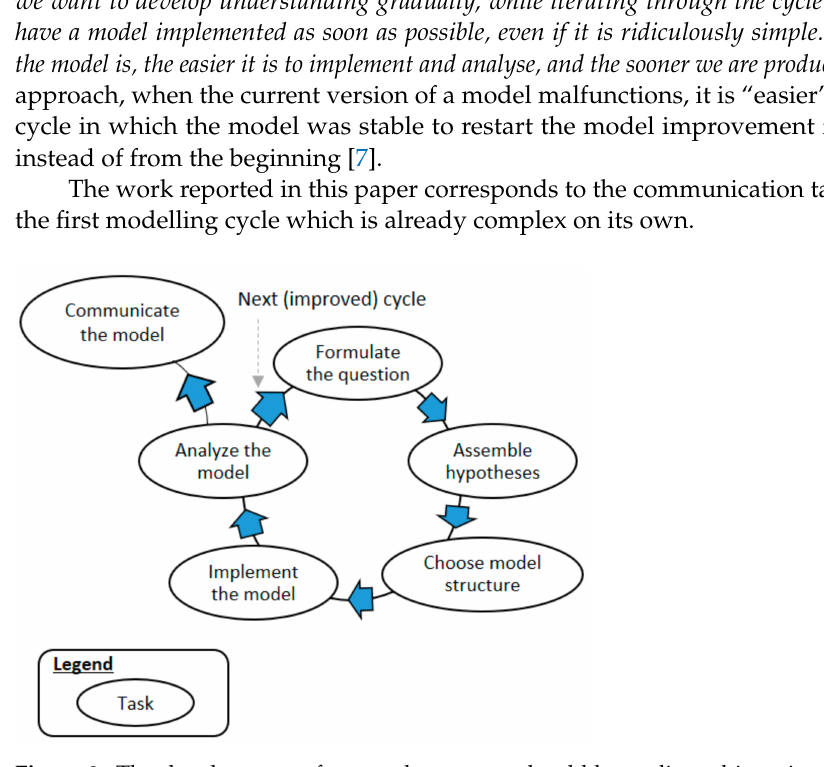
Figure 3. The development of a complex system should be cyclic and iterative, by starting with the simplest model possible. This paper presents the results of the first cycle. Source: